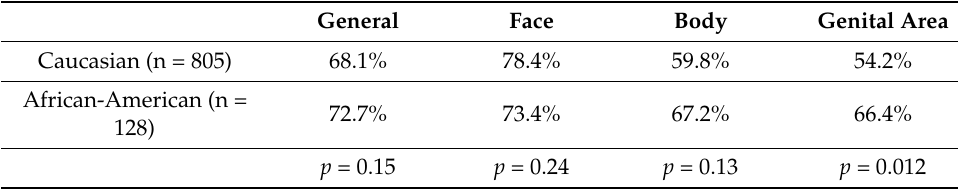
Table 3. Ethnic differences in perceptions of sensitive skin at different body sites.